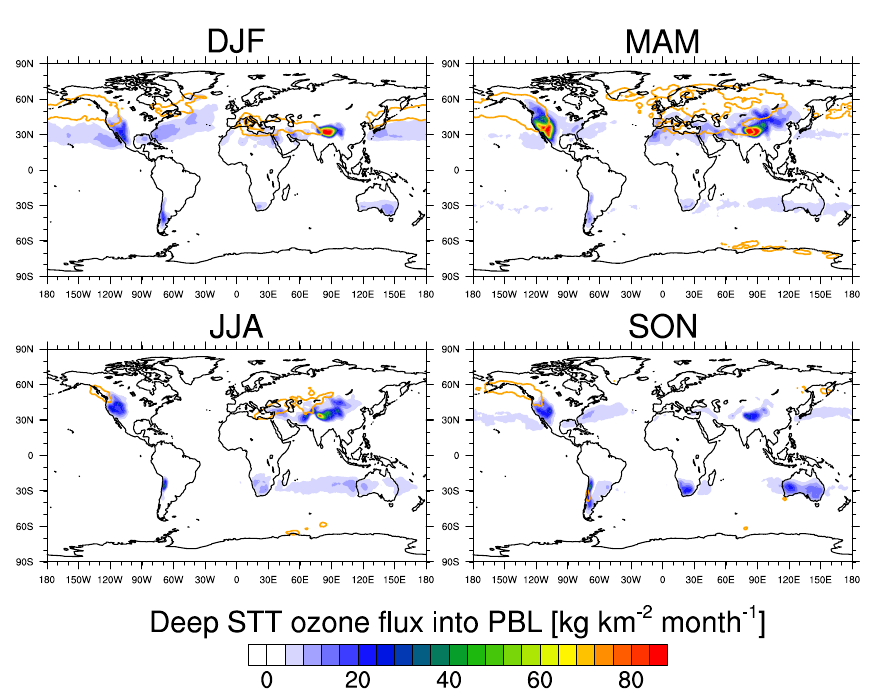
Fig. 17. Seasonally averaged deep STT ozone flux into the PBL for 1979–2011. For this calculation, the ozone concentration is kept constant along the trajectories after crossing the tropopause. The orange contours indicate areas where the ozone flux across the tropopause due to deep STT is higher than 7kgkm − 2 month − 1